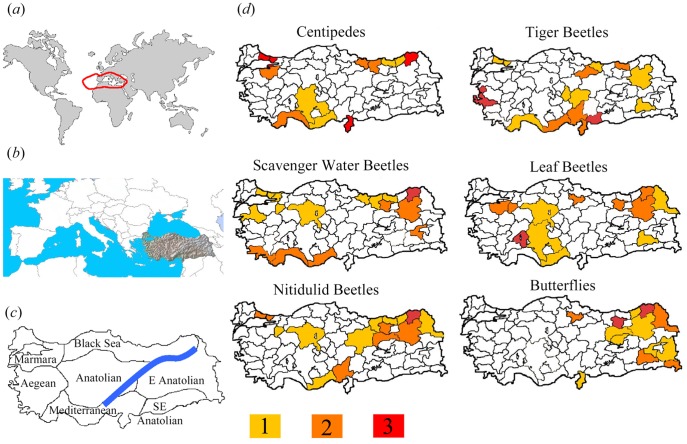
The Mediterranean global hotspot (a), location of the study area (Turkey) (b), its main biogeographical regions (c), and hotspots for different arthropod groups (d).Position of the Anatolian Diagonal, a major biogeographical barrier, is shown in panel c. For each group, hotspots were calculated as the first 10 per cent rank in three different diversity metrics (species richness, species richness-area ratio, residual from the species-area relationship). Different grey tones indicate if a certain hotspot has been identified by one, two or all three metrics.